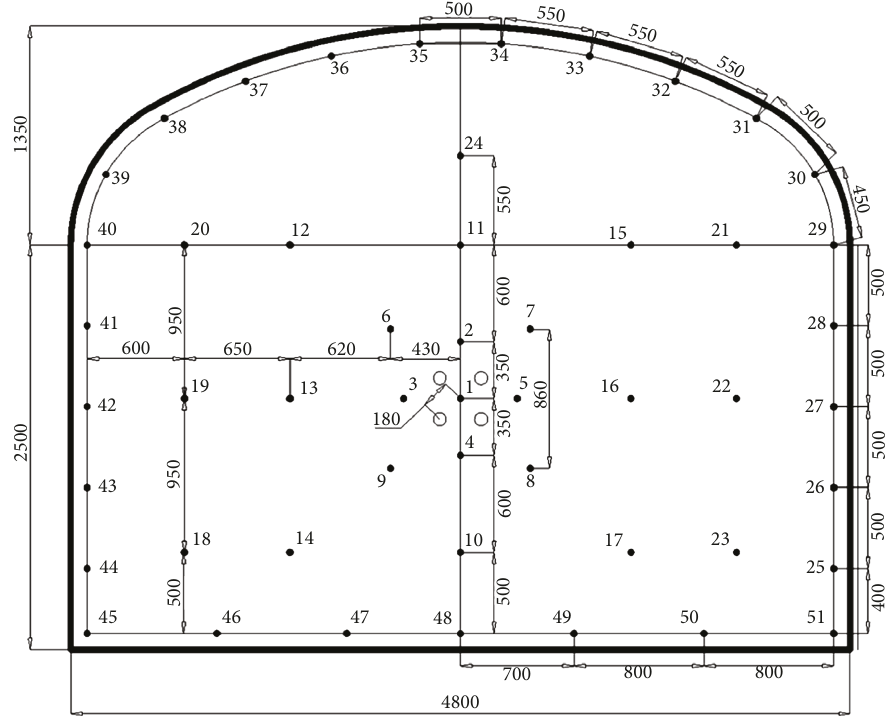
Figure 4: Blast hole layout of the Xingshan iron mine roadway (mm).